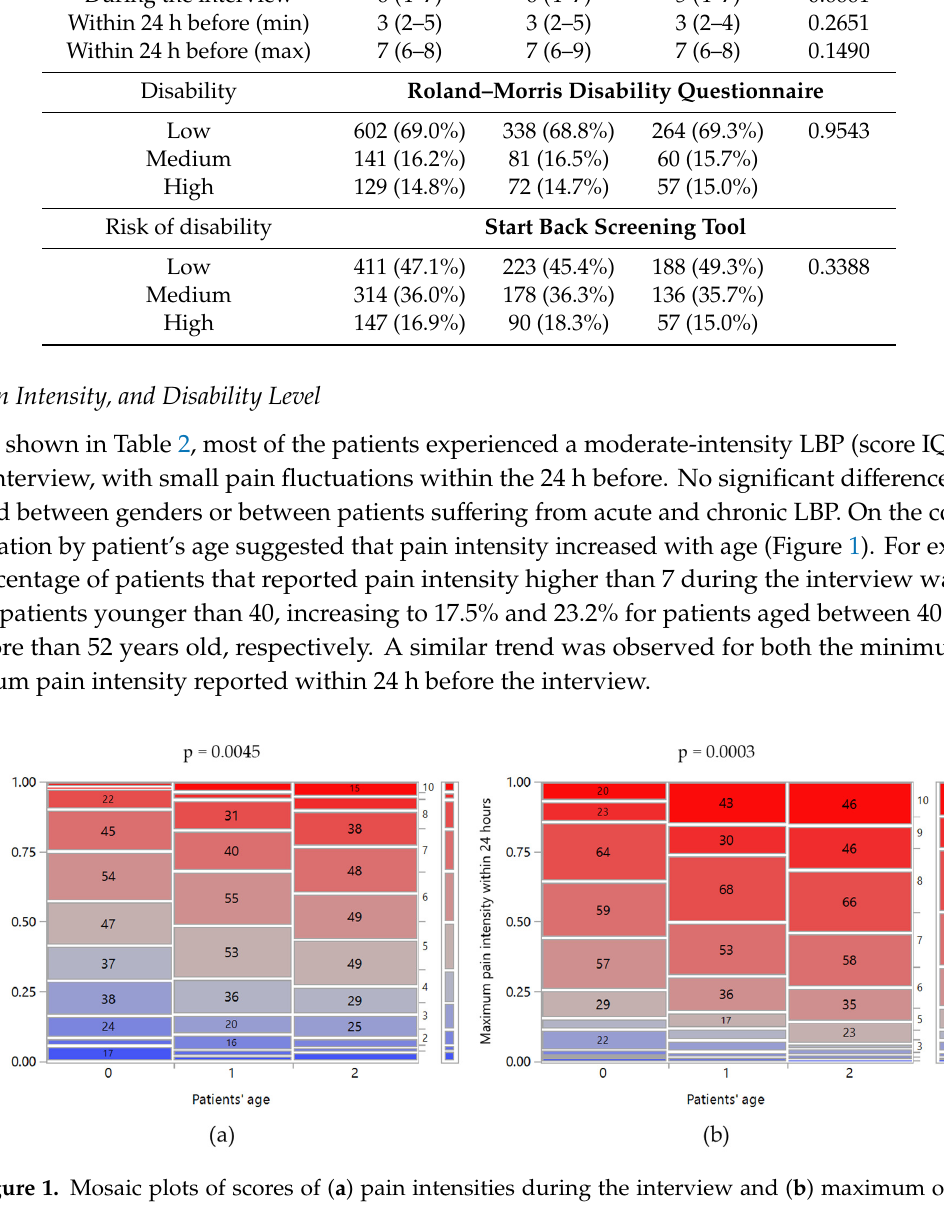
Table 2. The intensity of LBP based on a Pain Rating Scale (0: pain absence, 10 the worst pain possible), and patient distribution (No.; %) based on Roland and Morris Disability Questionnaire (RMDQ) and Start Back Screening Tool (SBST).